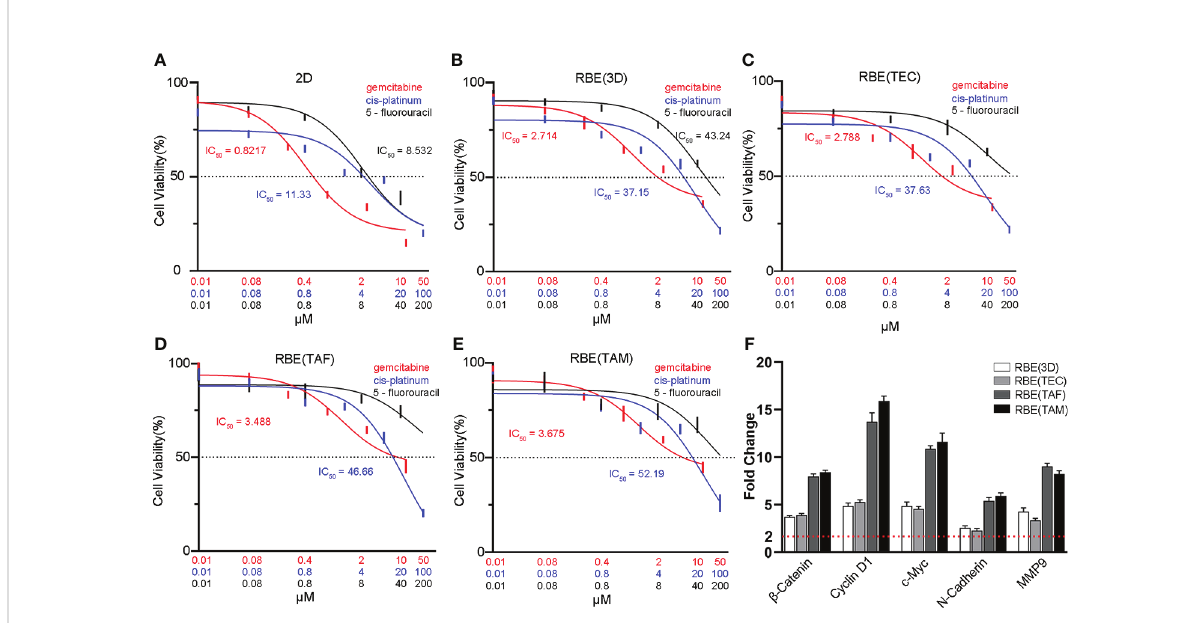
FIGURE 4 Characterization of drug metabolism and genes expression in different models. Dose-response curves and half maximal inhibitory concentration (IC50) of gemcitabine, cis-platinum and 5- fl uorouracil in 2D cell model (A) , the RBE(3D) (B) , RBE(TEC) (C) , RBE(TAF) (D) and RBE(TAM) (E) after 72 h of incubation. Compared with 2D RBE cells, cells in 3D bioprinted models had higher IC50 values, especially in RBE(TAF) and RBE(TAM). (F) qRT-PCR assays showed that 3D bioprinting upregulated the expression of Wnt/ b -catenin pathway-related genes ( b -Catenin, Cyclin D1 and c- Myc) and epithelial-mesenchymal transition (EMT) markers (N-Cadherin and MMP9), compared with 2D RBE cells. The experiments were replicated at least three